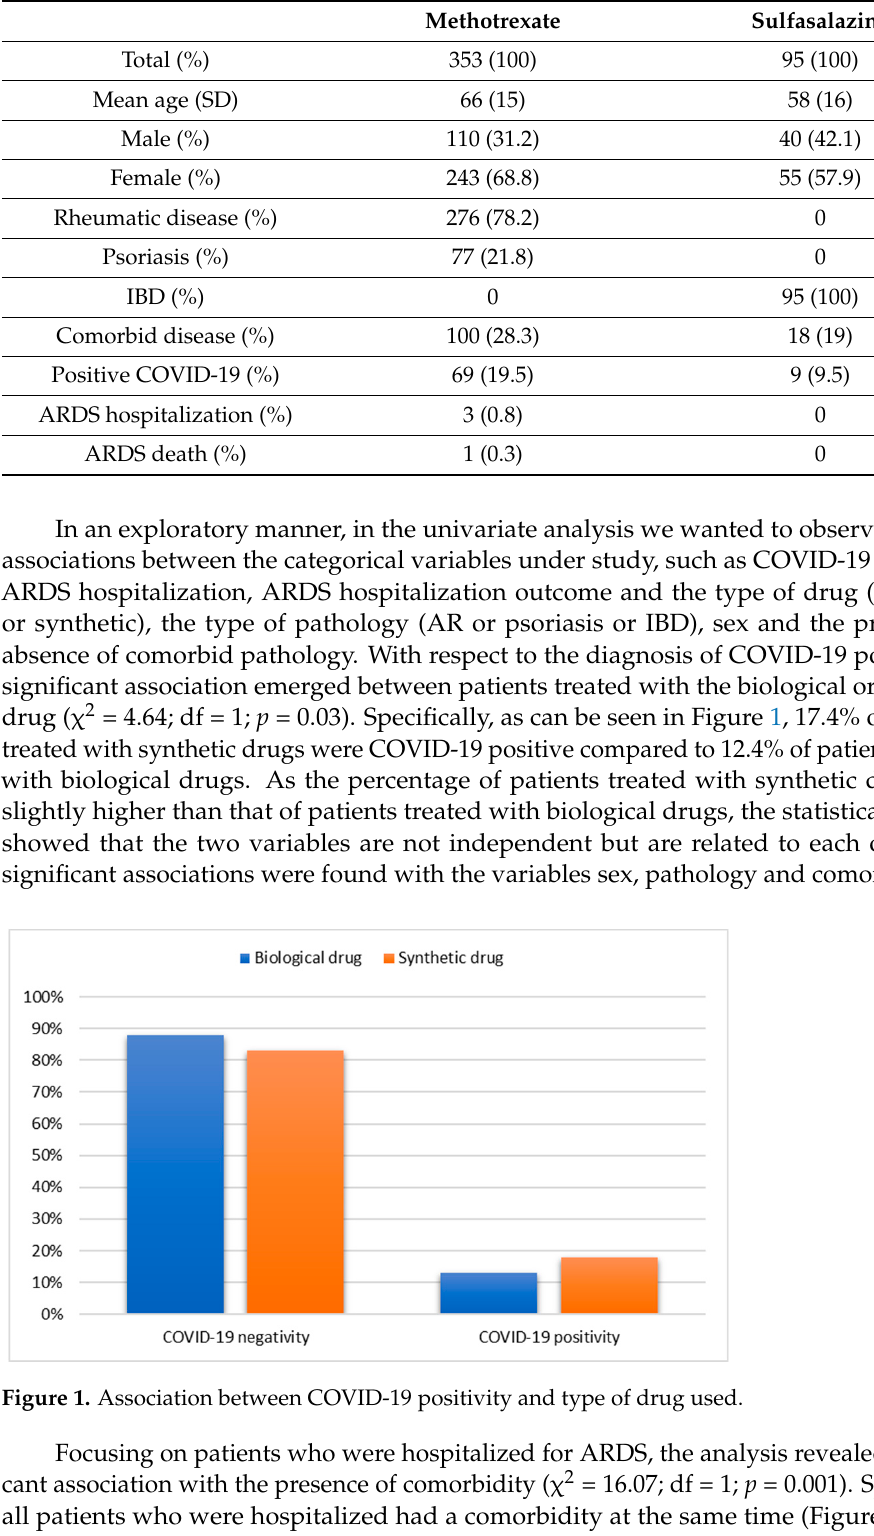
Table 3. Characteristics of patients treated with synthetic drugs.